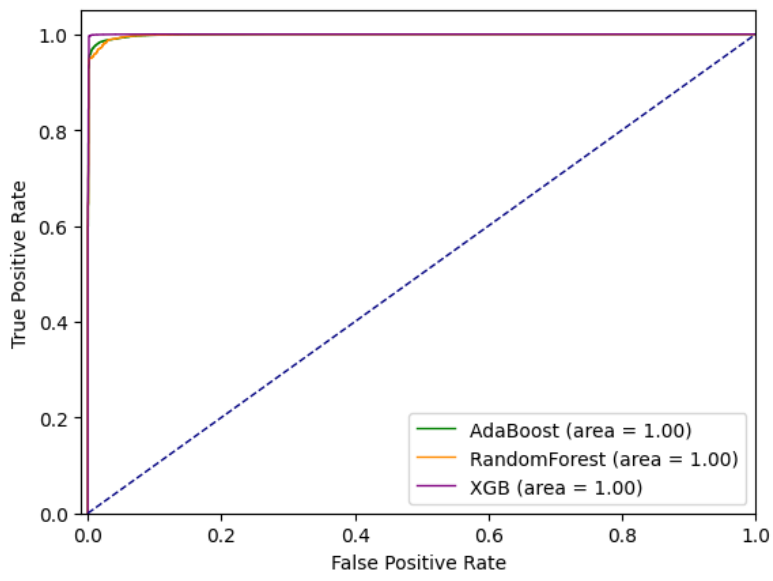
Figure 9. Extended PaySim dataset—comparative ROC curve for ensemble methods.